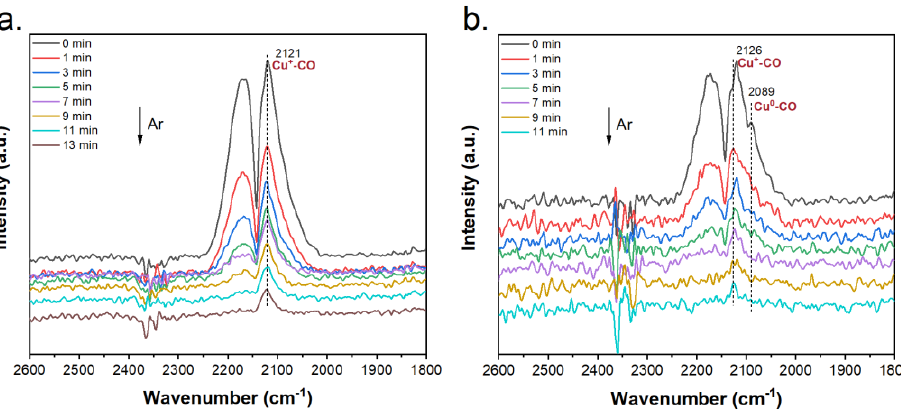
Figure 6. In situ DRIFTS of CO adsorption on the CuFe/SiO 2 catalysts after reduction : (a) CuFe/SiO 2 -N and (b) CuFe/SiO 2 -T. N and ( b ) CuFe/SiO 2